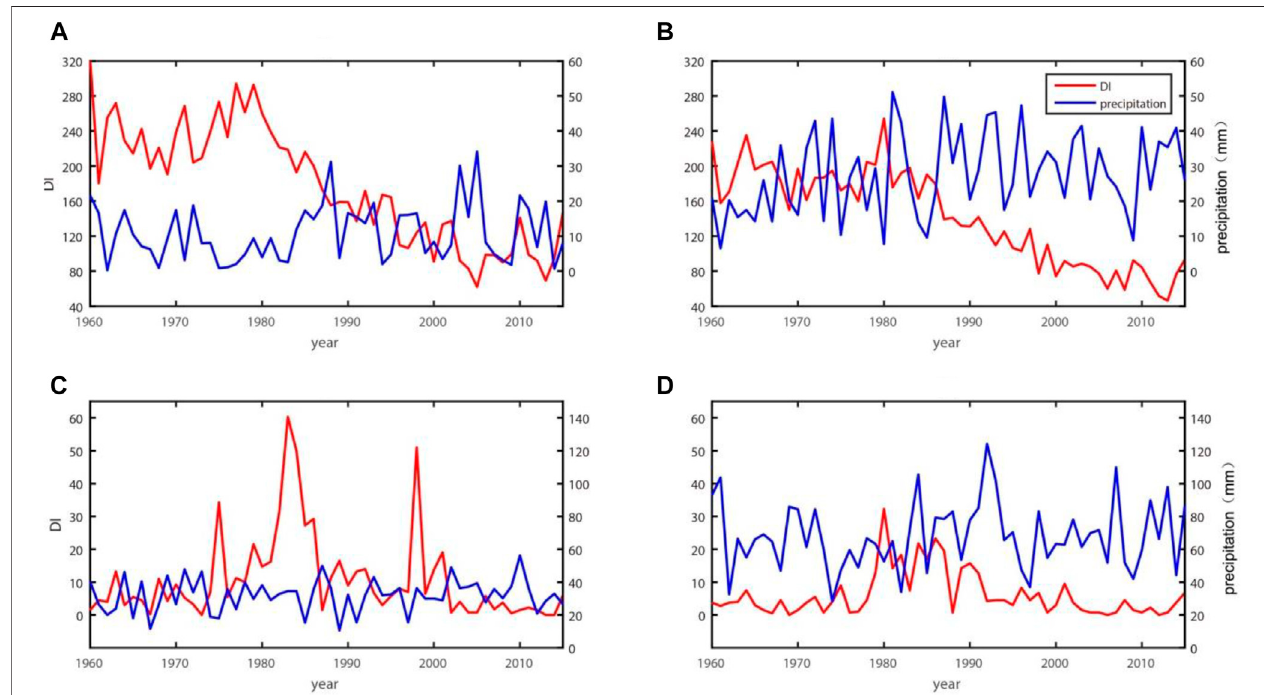
FIGURE 9 | Variations of DI and precipitation of Southern Xinjiang (A,B) and Northern Xinjiang (C,D) in spring (A,C) and summer (B,D) .